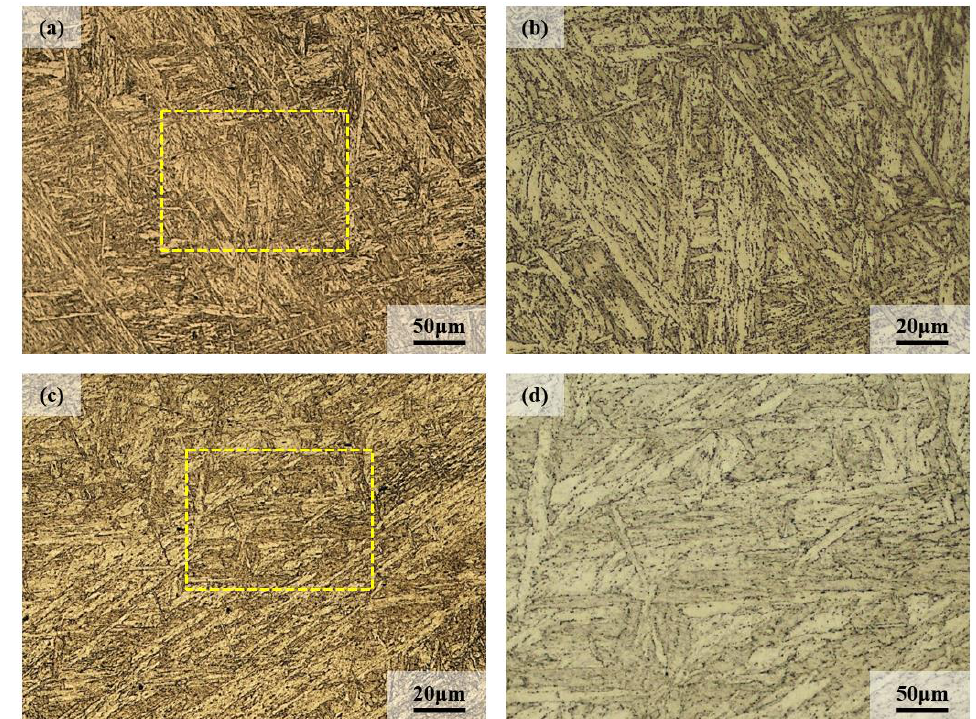
Figure 7. Optical microscope (OM) image of heat-resistant steel after heat treatment: ( a , b ) 9Cr–1.5Mo–1Co, ( c , d ) 9Cr–3W–3Co.